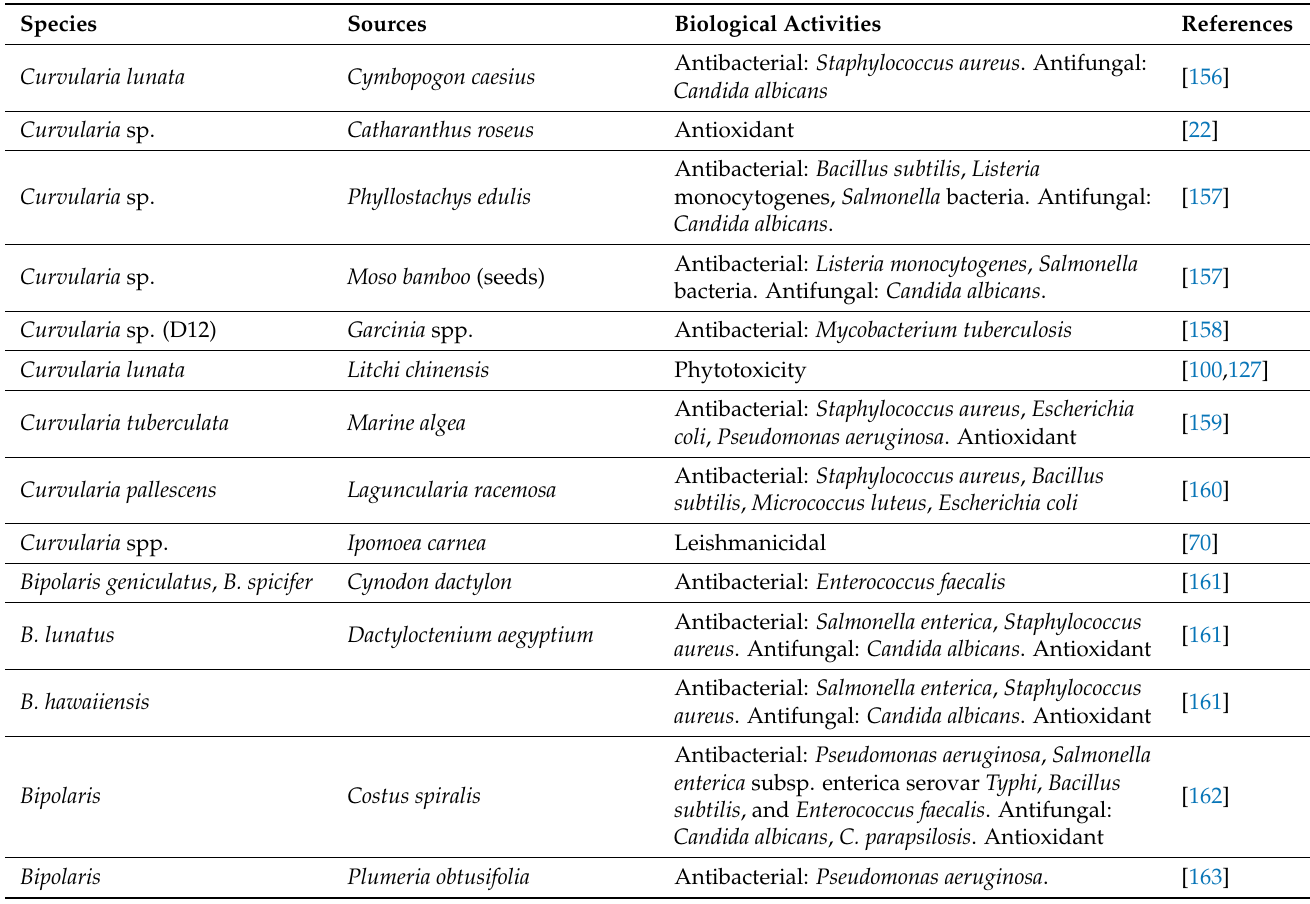
Table 5. Biological activities of Curvularia and Bipolaris